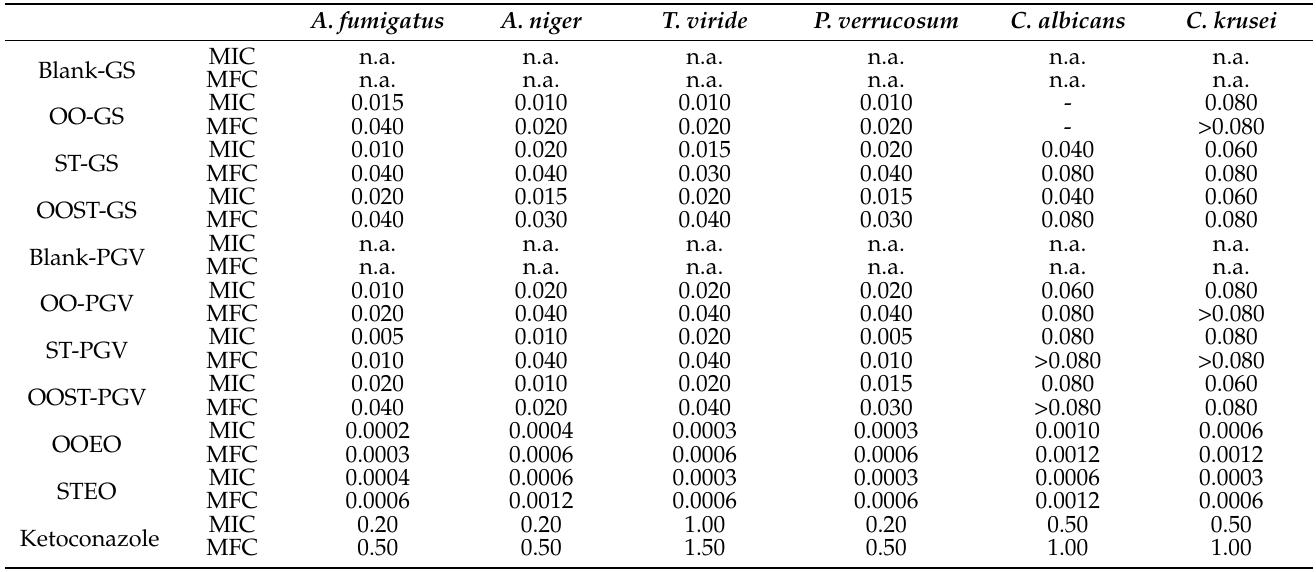
Table 6. Antifungal activity (mg EO/mL of medium) of pure and formulated EOs of O. onites (OOEO) and S. thymbra